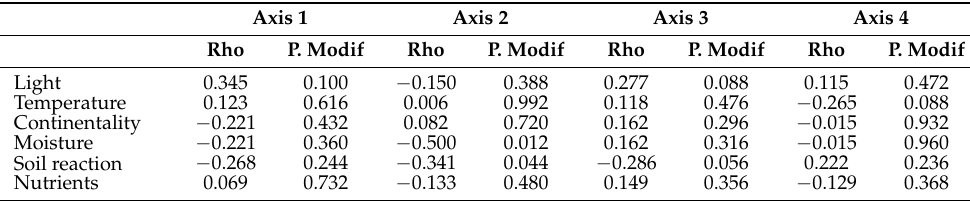
Table 3. Significance of Spearman’s rank correlation of mean EIVs with four main DCA axes within studied riparian forests using a modified permutation test.